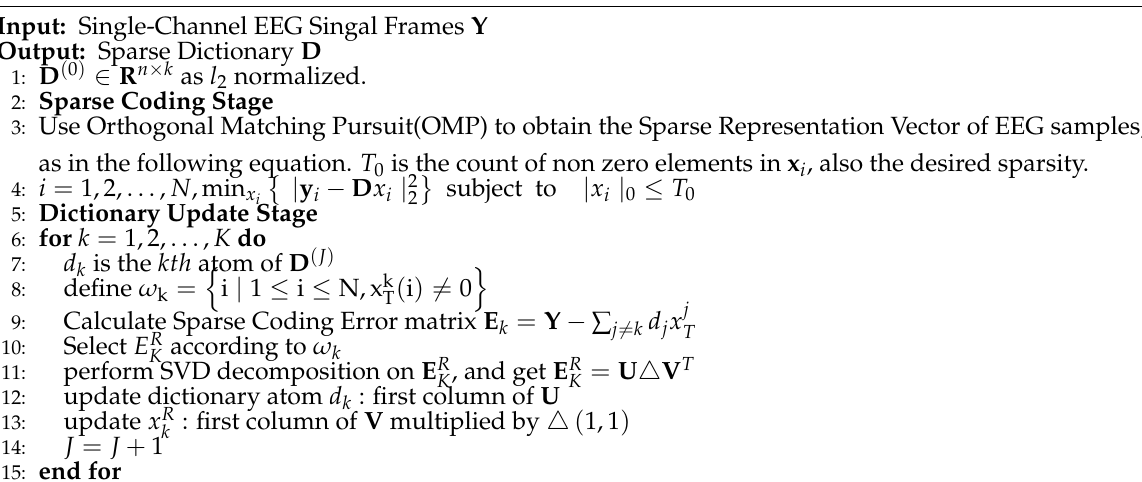
Algorithm 1 K-SVD Dictionary-Learning Algorithm.